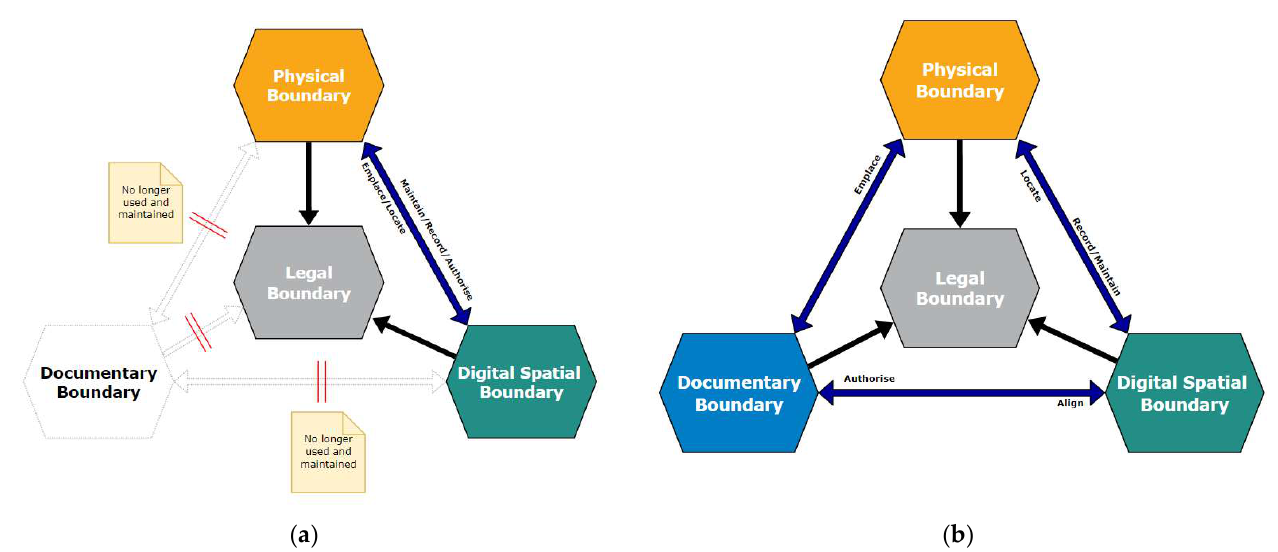
Figure 12. Evaluation of land boundaries and inconsistencies based on cadastral triangular model (CTM) in the post-digitisation phase; ( a ) CTM for North Macedonia in the pre-digitisation period; ( b ) CTM for Slovenia in the post-digitisation period.